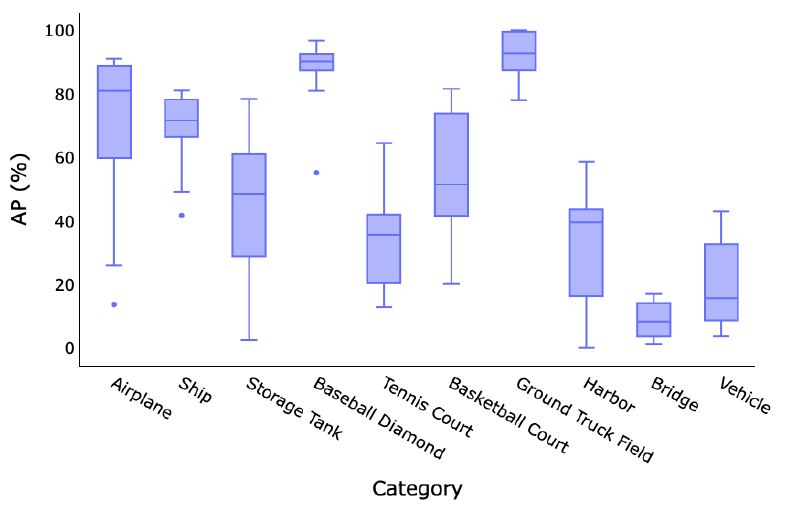
Figure 10. Box plot of average precision by class of all the WSOD/RSWOD methods on the NWPU VHR-10.v2 dataset. It is possible to notice that there is high inter-class performance variance based on the classes’ difficulty (e.g., Ground Track Field and